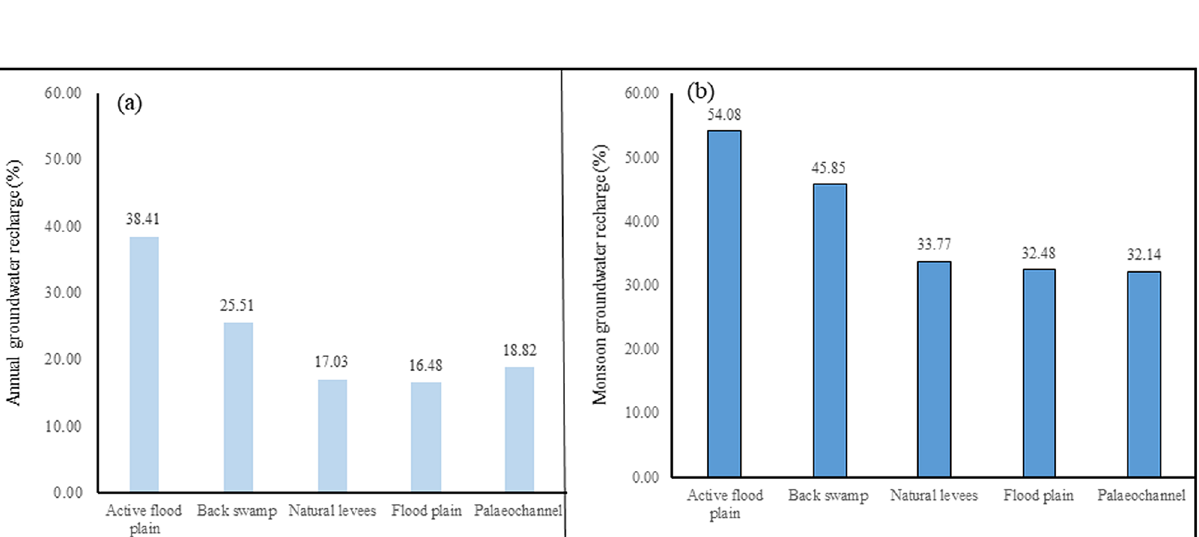
Figure 5. Cross plot the percentage of natural groundwater recharge with soil infiltration rate in a part of the Ganga basin during the monsoon period.